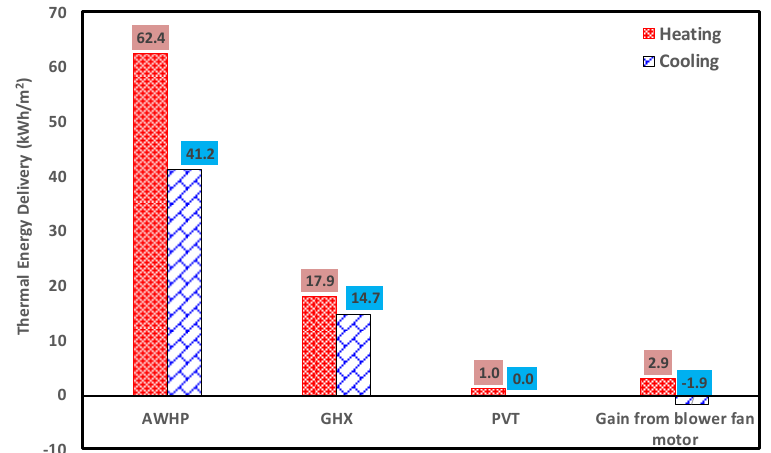
Figure 7. Breakdown of annual thermal energy delivery of the hybrid trigeneration system under optimum design conditions in heating and cooling periods.